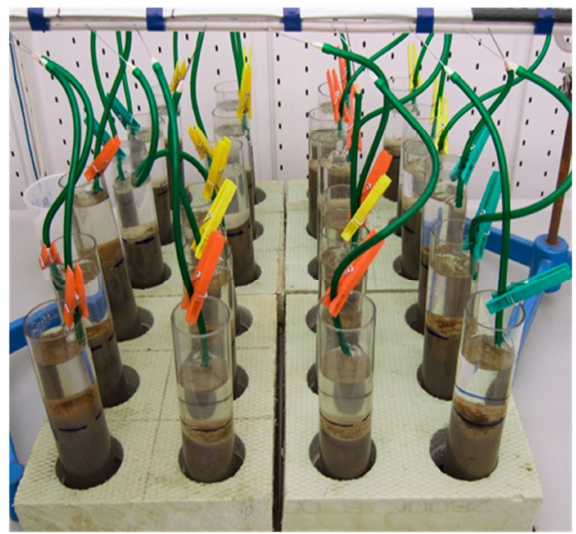
Fig. 1. Experimental set-up of the lab experiment before induction of anoxia ( T 1 ) Figure 1. Experimental set up of the lab experiment before induction of anoxia (T